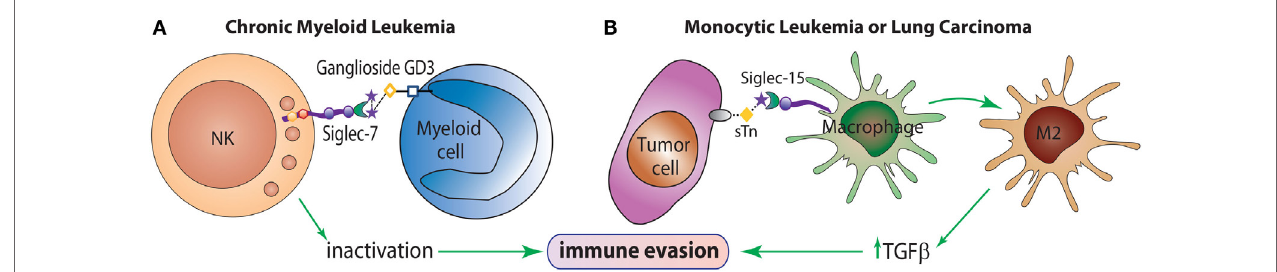
FiGURe 3 | The role of siglecs in immune evasion mechanisms . (A) Siglec-7 is expressed predominantly on NK cells and inhibits NK cell cytotoxicity toward target cells overexpressing the α (2 → 8)-disialic acid-bearing ganglioside, GD3. (B) Siglec-15 recognizes the tumor sialyl-Tn (sTn) antigen and transduces an intracellular signal leading to enhance TGF- β secretion and polarization toward an M2-like macrophage profile, which contributes to tumor